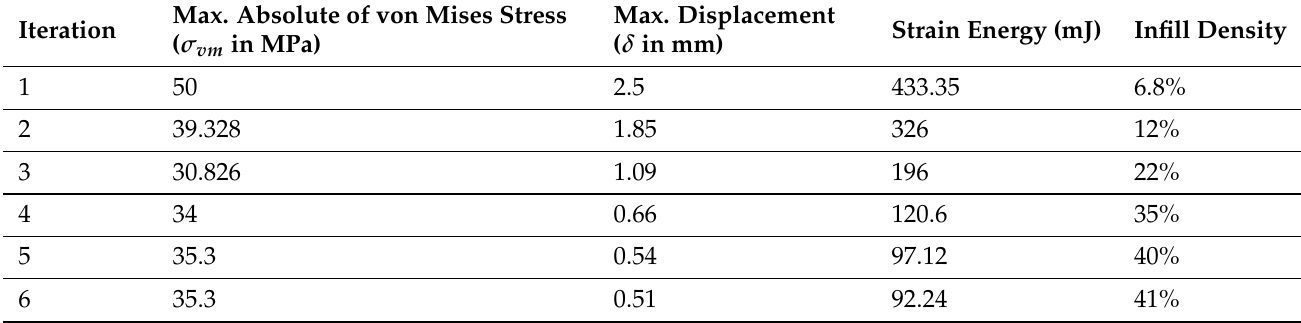
Table 4. FE Simulation results for case-study subjected to 4-point bending with threshold stress = 10 MPa and minimum length of a side of the infill design (L) ≥ 2.4 mm as stopping criteria. Iteration